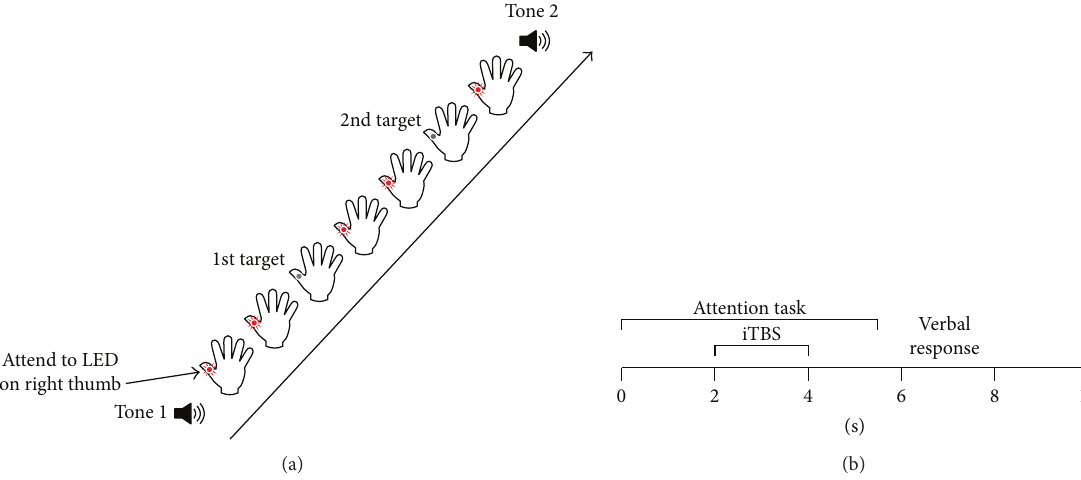
Figure 1: Attention task and trial timeline. (a) Attention task. Participants were instructed to attend to a continuously lit LED attached to the right thumb and to count the number of interruptions (“OFF” periods). A tone indicated the start and end of each trial. (b) Trial timeline. Each trial lasted a total of 10 seconds, with iTBS occurring during the attention task.